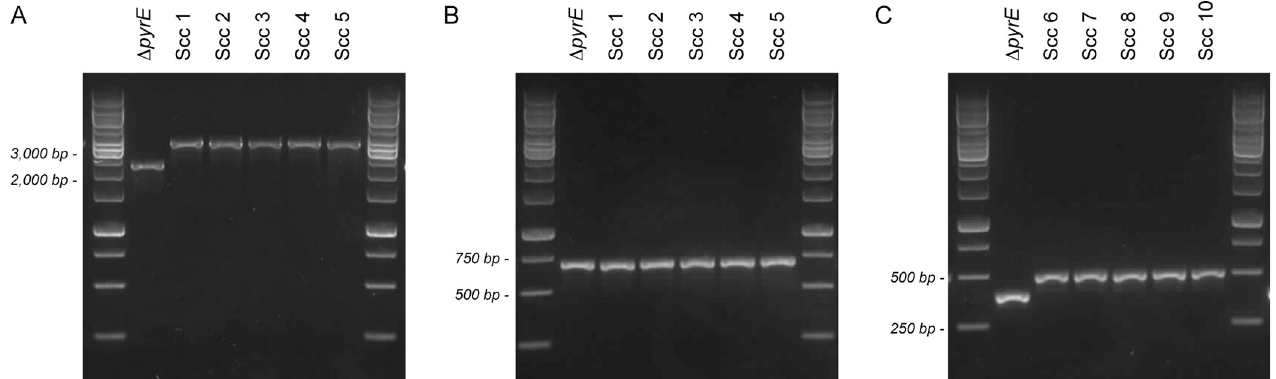
Fig 7. Confirmation of genomic integration of the pyrE gene by PCR. (A) Confirmation of the integration of a fragment in the CIS1 region in five single cell colonies (Scc 1 to Scc 5) obtained after transformation of strain DIB 104C D pyrE with plasmid pUC19-P slp -pyrE. Strain DIB 104C D pyrE was included as control (D pyrE ). (B) Confirmation of the mutant version of the pyrE gene in the single cell colonies Scc 1 to Scc 5. (C) Confirmation of the wild type pyrE gene in five single cell colonies (Scc 6 to Scc 10) obtained after transformation of strain DIB 104C D pyrE with a linear DNA fragment containing the wild type pyrE